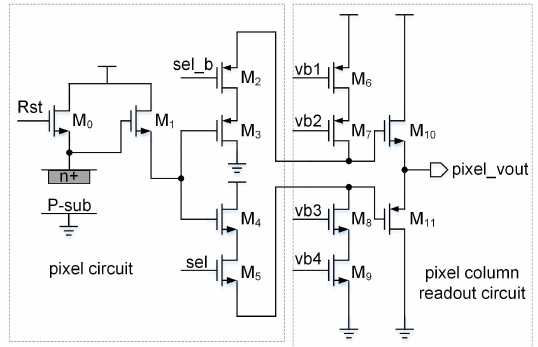
Figure 8. Schematic of the pixel circuit.